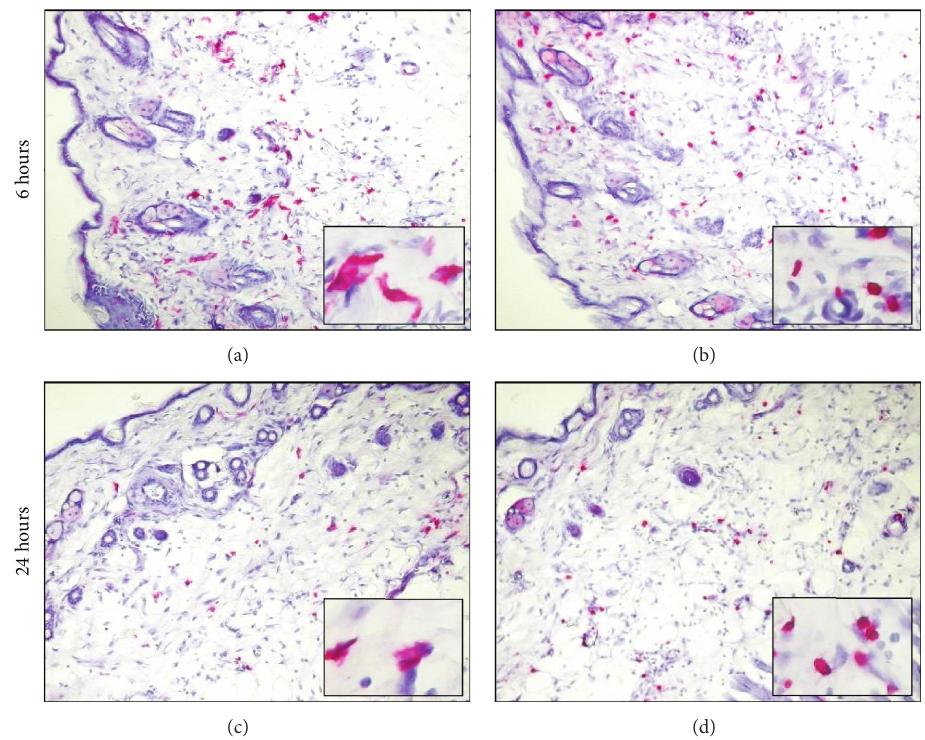
Figure 2: APCs infiltrate vaccinated skin. Six hours after intradermal EP vaccination dendritic (a) and CD4 (b) cells infiltrate the electroporated skin and decrease starting at 24 hours after treatment ((c), (d)). Red staining shows positivity for CD11 ((a), (c)) or CD4 ((b), (d)) molecule. Magnification: × 200, insets: × 400. Images are representative of three independent experiments.